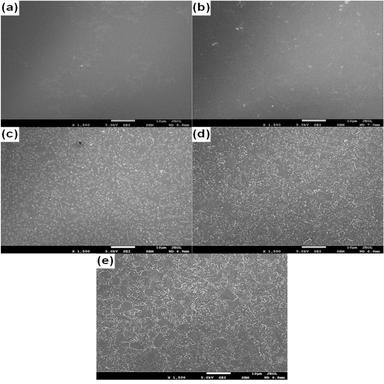
SEM images of the prepared PVA/GA-NQNs nanocomposite film samples, (a) Pure PVA, (b) PVA/Gr, (c) PVA/Gr-3 wt% NQNs, (d) PVA/Gr-7 wt% NQNs, and (e) PVA/Gr-11 wt% NQNs.